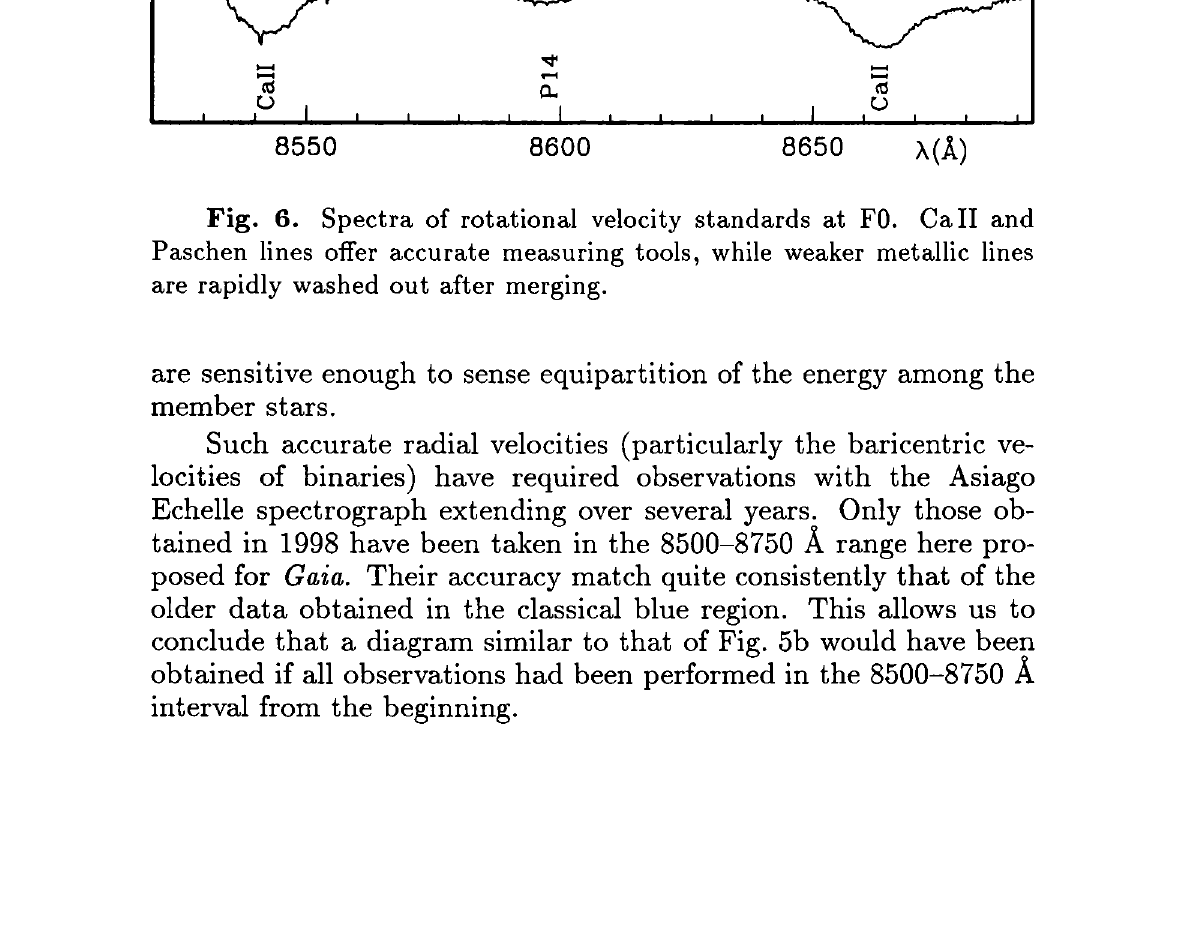
Fig. 6. Spectra of rotational velocity standards at FO. Call and Paschen lines offer accurate measuring tools, while weaker metallic lines are rapidly washed out after